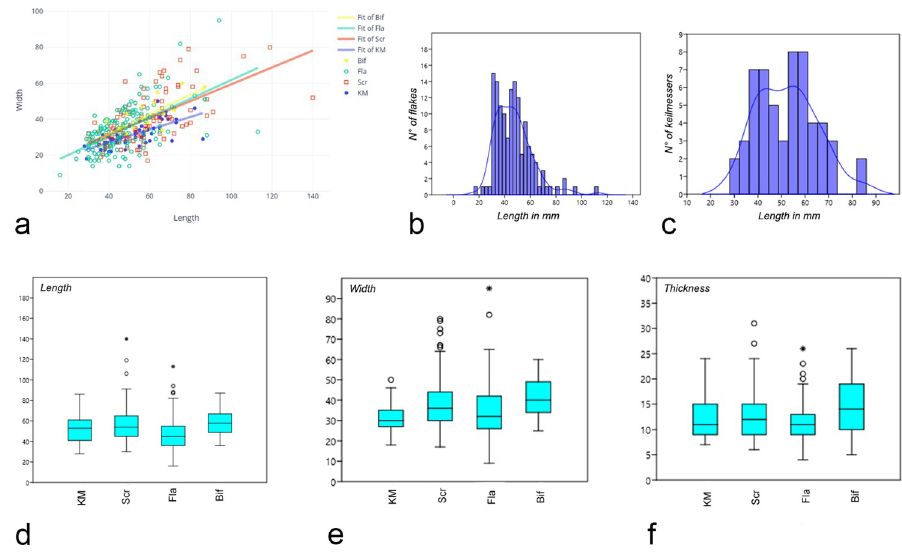
Fig 6. Dimensional distribution (length/width) of the analyzed artifacts showed for typology (a); histograms of dimensional classes of flakes (b) and Keilmesser (c) length; boxplot showing respectively length (d), width (e), thickness (f) of the tool-types classes (“KM”: Keilmesser; “Scr”: scrapers; “Fla”: flakes; “Bif”: other bifacial tools).